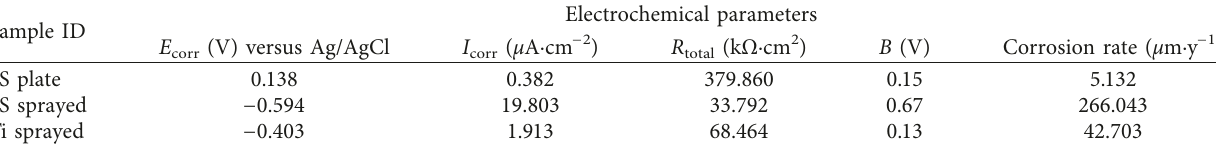
Table 2: Electrochemical parameters extracted after fitting of potentiodynamic plots to the Tafel region. Sample